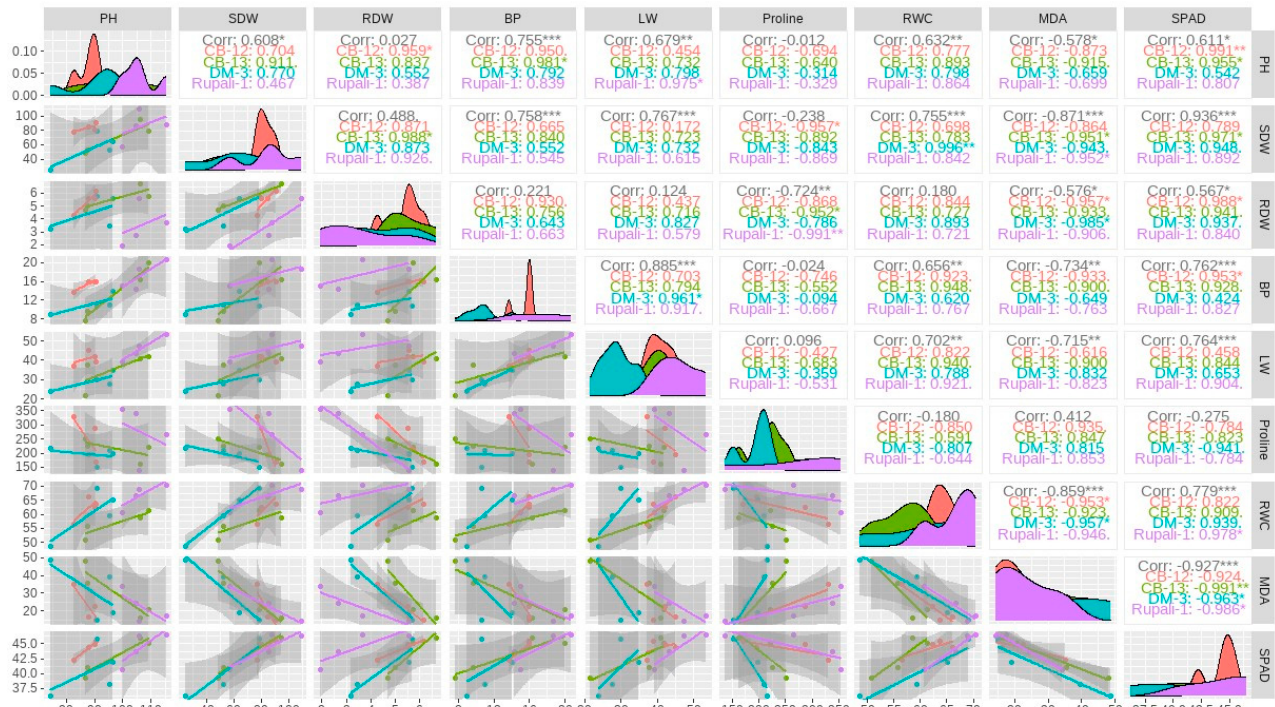
Figure 5. Spearman correlation matrix among the growth and yield traits of four investigated cotton cultivars. The upper triangle represents the type of relationships (significant or non-significant) and the lower part indicates the regression relationship with confidence level among the cotton cultivars. *, ** and *** indicate significant correlations at p < 0.05, p < 0.01 and p < 0.001 levels, respectively. BP, boll plant − 1 ; Corr, correlation; LW, lint weight; MDA, malondialdehyde; PH, plant height; RDW,